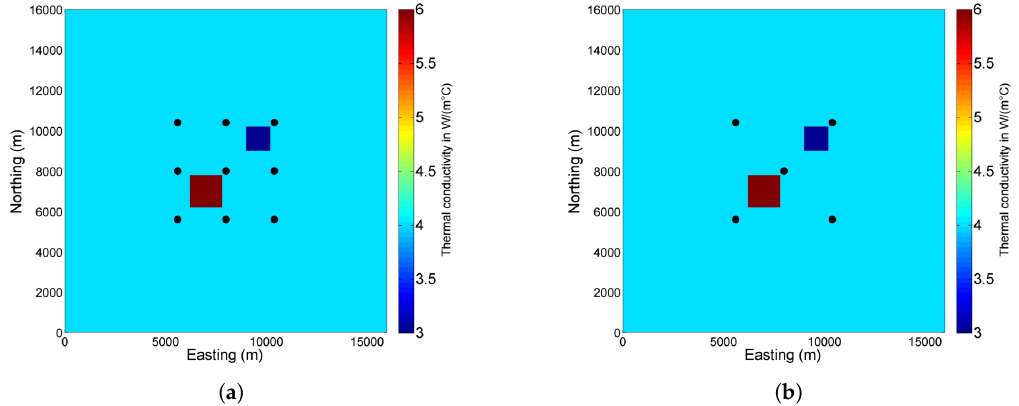
Figure 3. Plan views of borehole locations and thermal conductivity anomalies used for inversions of sythetic borehole temperature data, for ( a ) a nine-well configuration and ( b ) a five-well